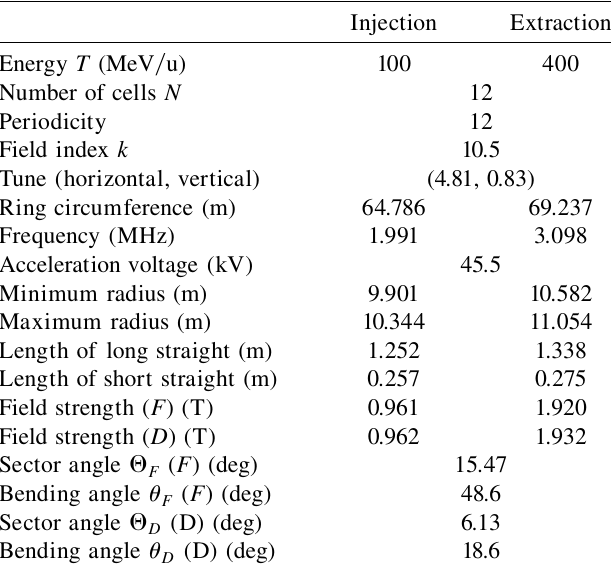
TABLE VII. Basic lattice parameters of the HE-FFAG ring.